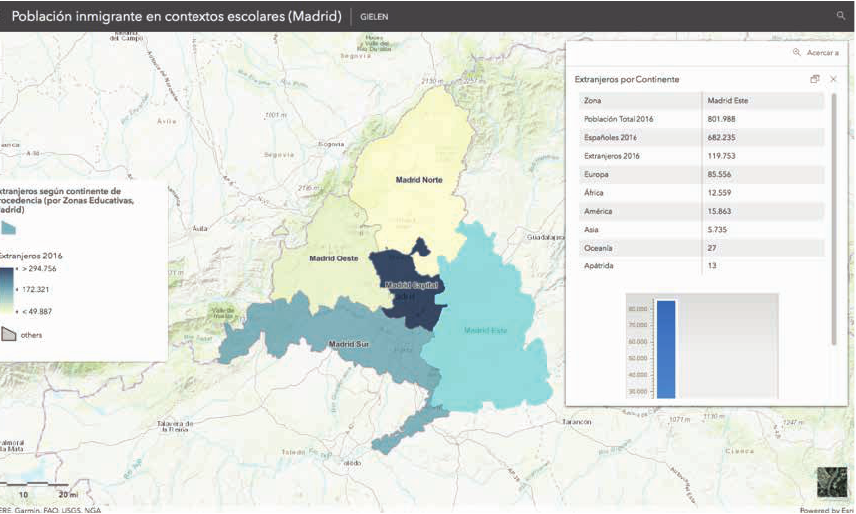
Figure 6: Sample of sociodemographic study performed using the Web Mapping Application “Immigrant population in educa- tional